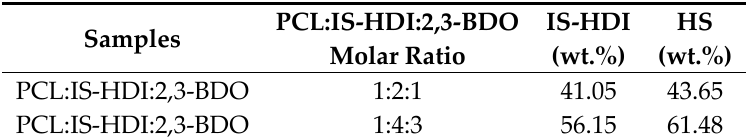
Table 1. Designation, molar ratio, IS-HDI content and hard segment content of the synthesized